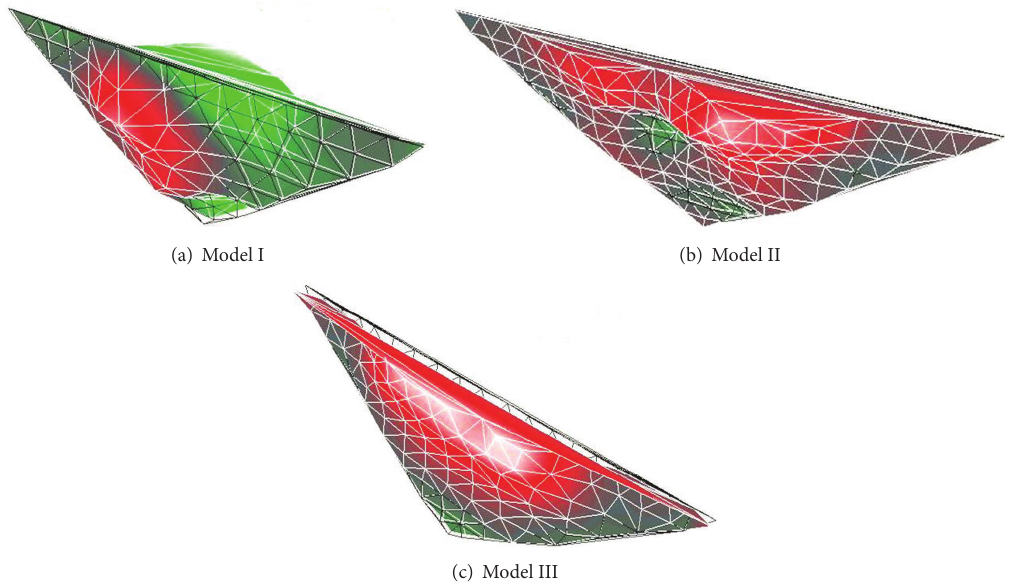
Figure 3: First-order mode shape in contrast to initial static shape (plain mesh).